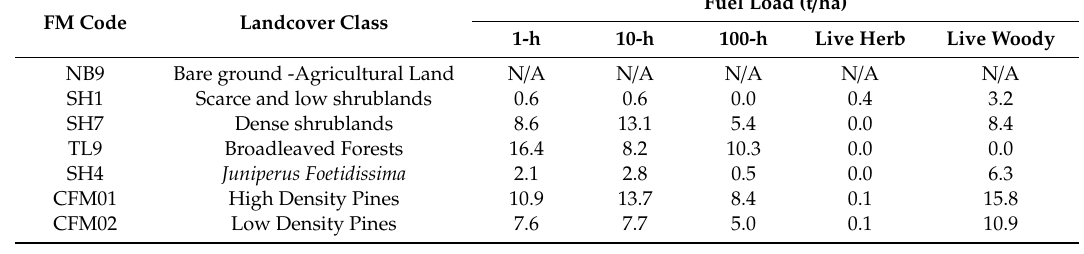
Table 3. Fuels models and corresponding land cover types used in the study. Table 2. Landcover classes identified in the study area.